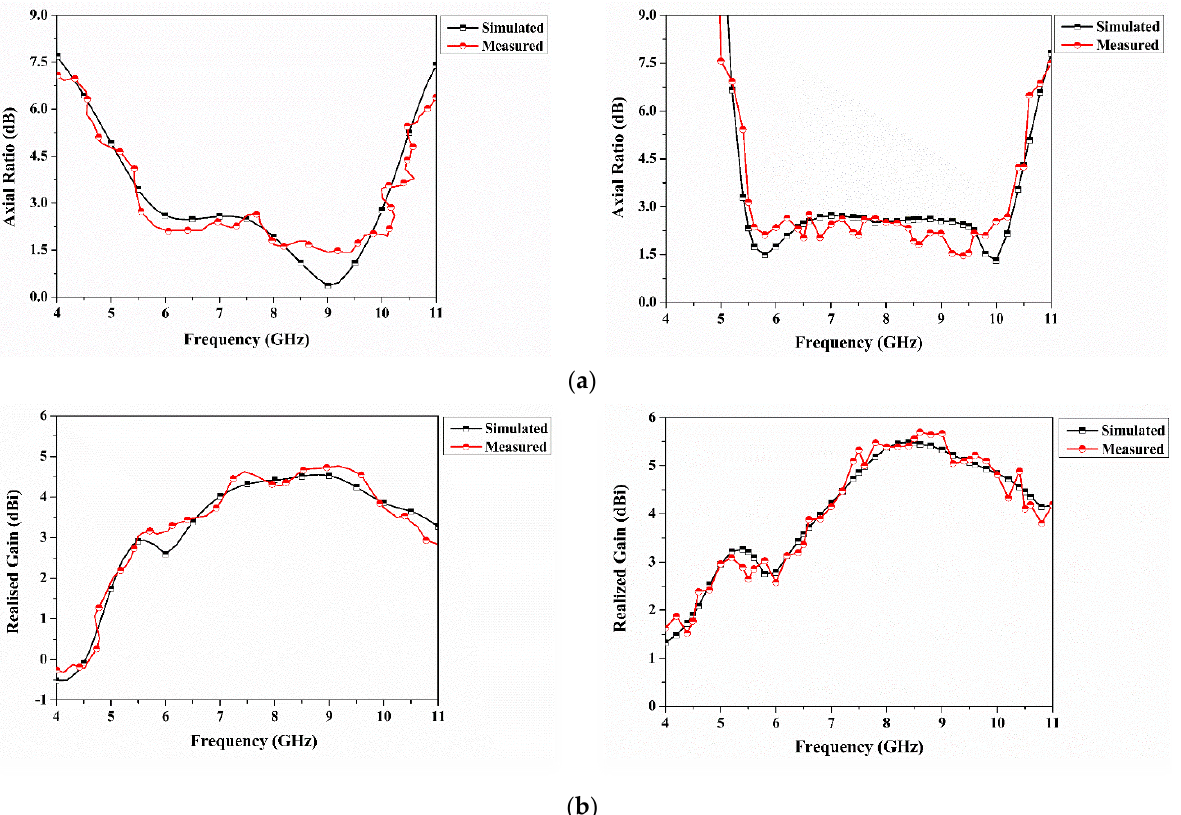
Figure 8. ( a ) Axial ratio of dual- and quad-port antenna and ( b ) Realized gain of dual- and quad- port antenna. antenna. Table 5. Comparison of dual port results. Table 5. Comparison of dual port results.